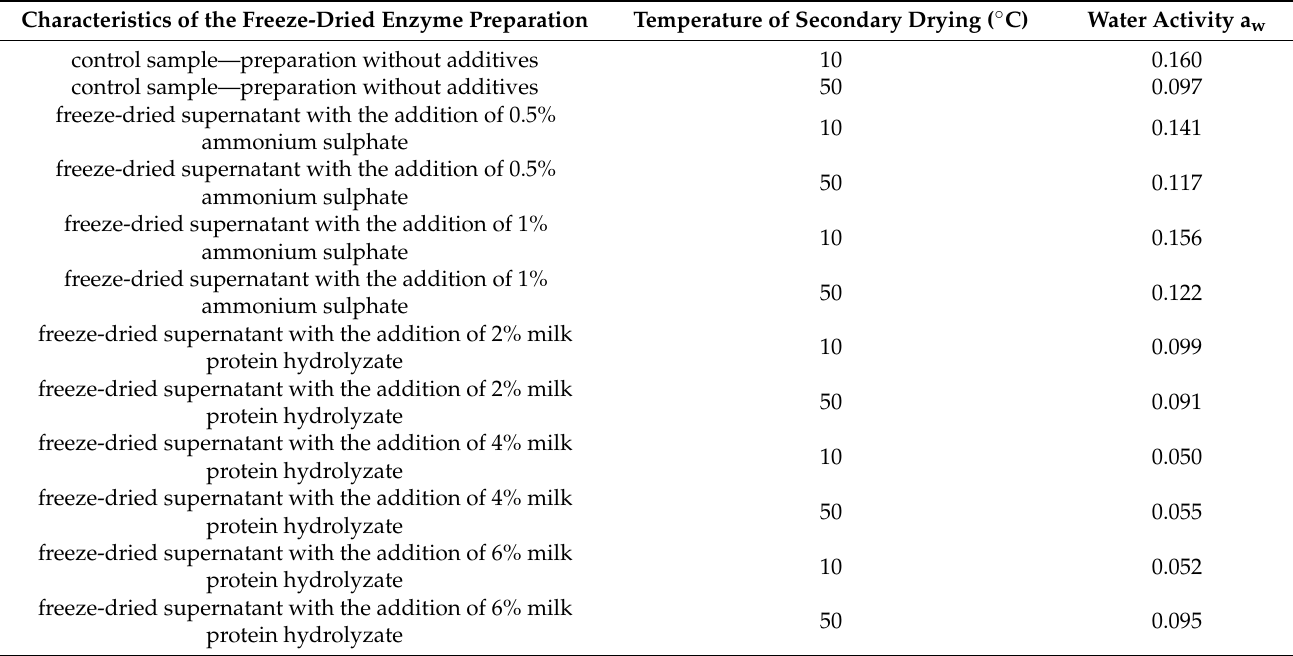
Table 1. The water activity of supernatants after the freeze-drying process.